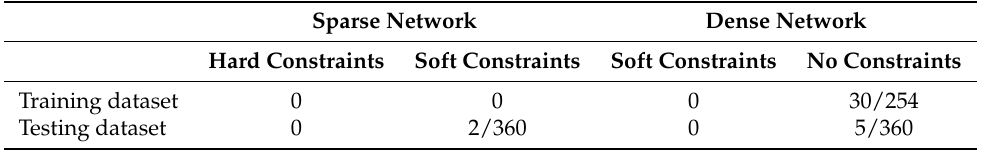
Table 4. The fraction of static arbitrage violations with Dupire penalization.